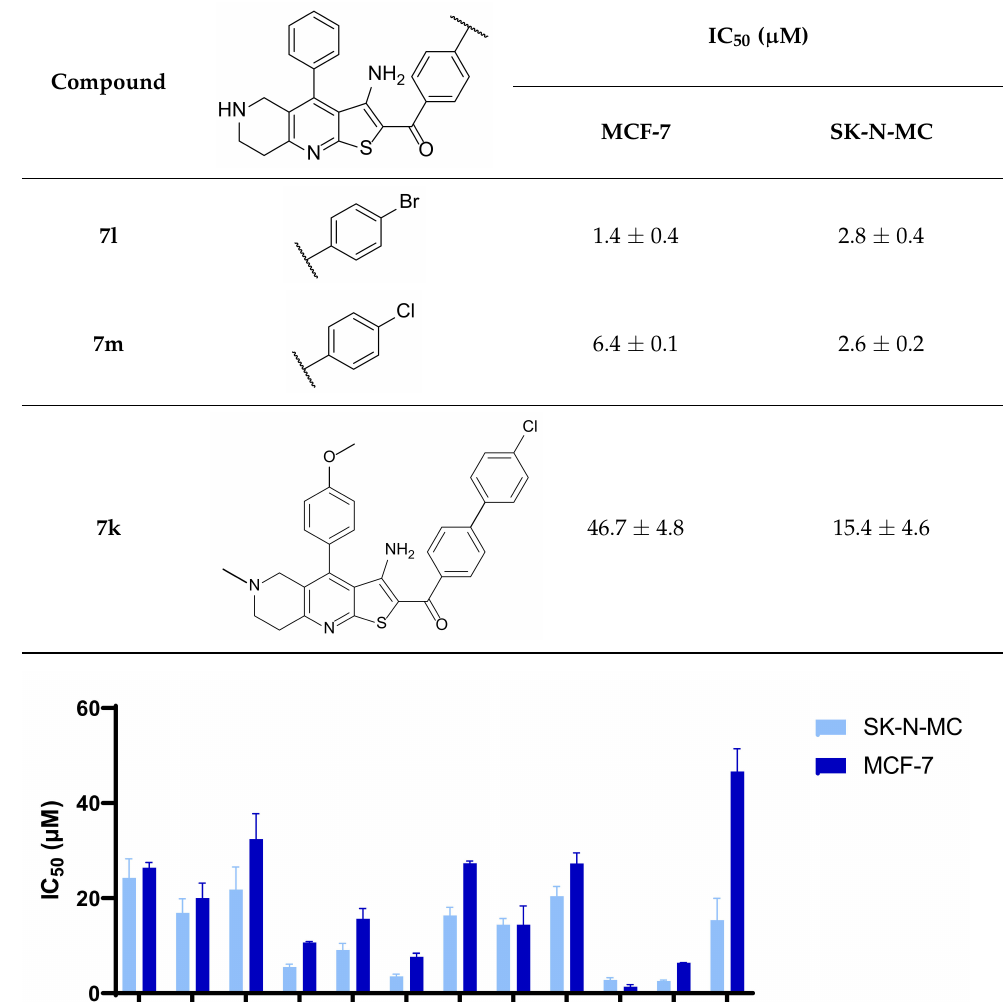
Table 3. IC 50 values for the antiproliferative activity of compounds 7l–k in the MCF-7 and SK-N-MC cell lines.